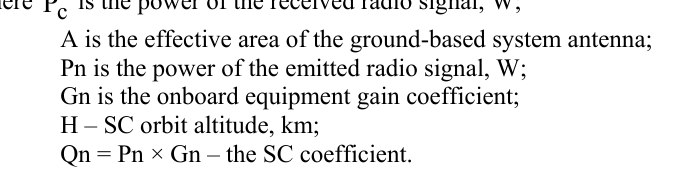
Table 1. Effective antenna area of ground control